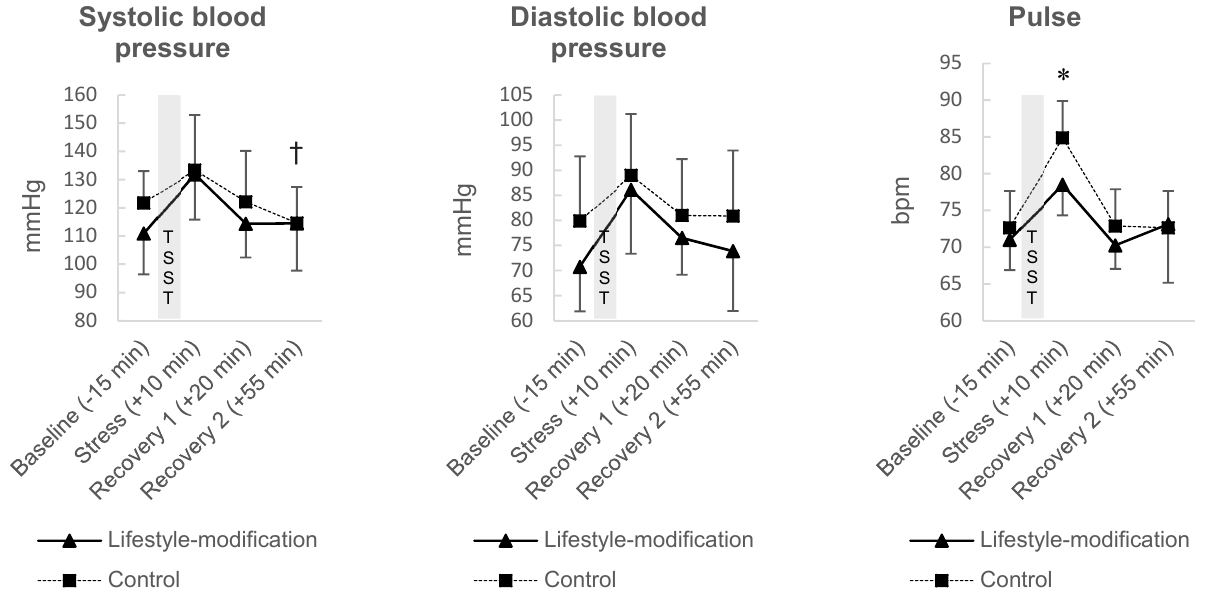
Figure 3. Results of the exploratory sub-study: Cardiovascular responses to the Trier Social Stress Test in the comprehensive lifestyle-modification group ( n = 8) and controls ( n = 8). Values expressed as mean ± standard deviation. mmHg = millimeter of mercury; bpm = beats per minute. * p < 0.05; † p < 0.10.